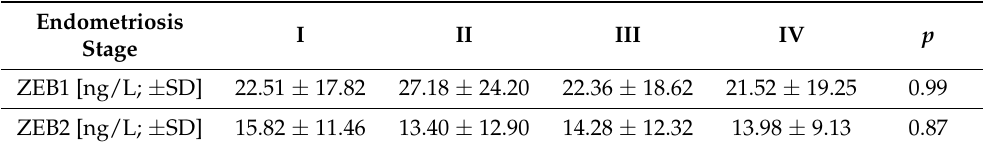
Table 4. Zinc finger E-box-binding homeobox 1 (ZEB1) and Zinc finger E-box-binding homeobox 2 (ZEB2) peritoneal concentrations depending on the stage of